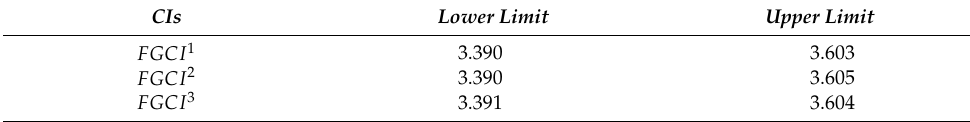
Figure 2. Pareto distribution in the log–log scale with the survival probability. Table 3. Confidence intervals with 2.5% and 97.5% limits for in-degree.